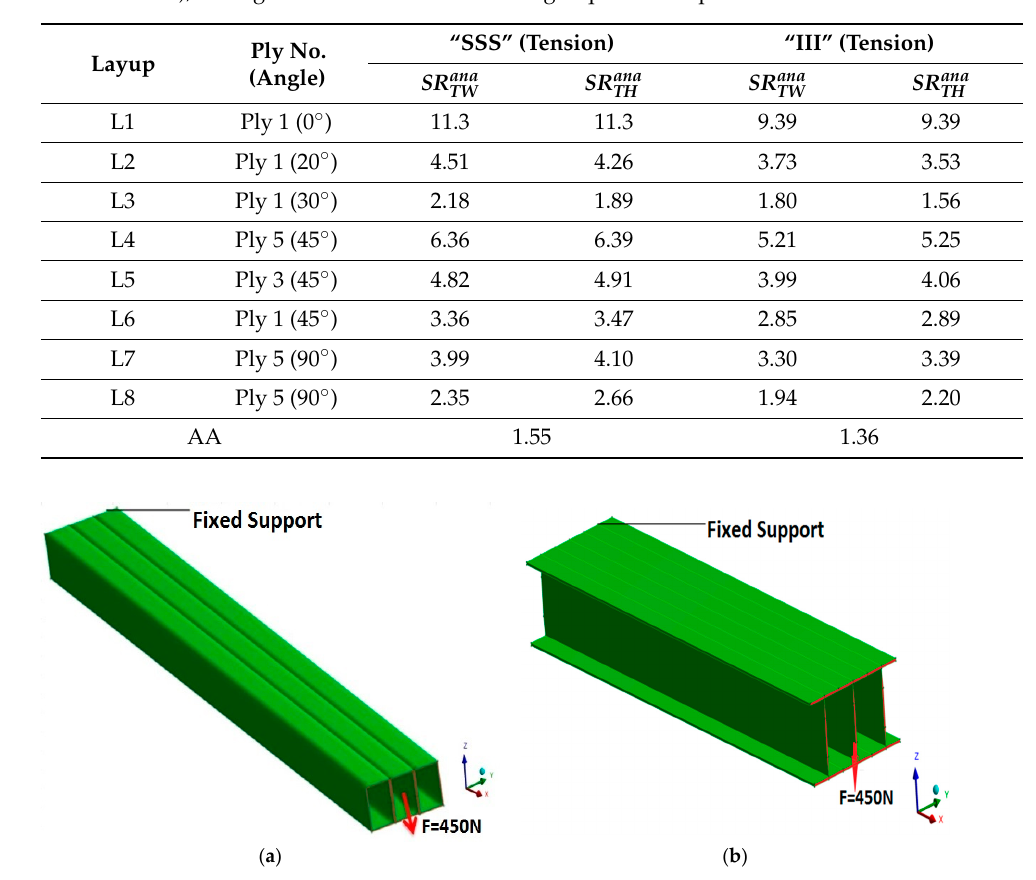
Table 4. Comparison of plies with minimum safety ratios (SRs) for the “SSS” and “III” beams (flange under tension); see Figure 3c for a laminate stacking sequence sample.